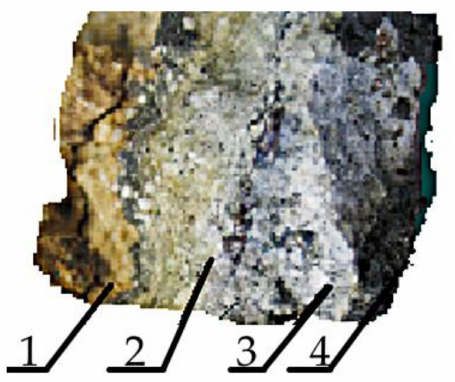
Figure 4. Sample embossed lining (photo taken at the moment of embossing in the furnace, during the production process): 1—Loose layer consisting of quartzite and boric acid; 2—Intermediate, half-baked layer consisting of quartzite and tridymite; 3—Sintered layer consisting of tridymite and a small amount of glazed phase; 4—Coated